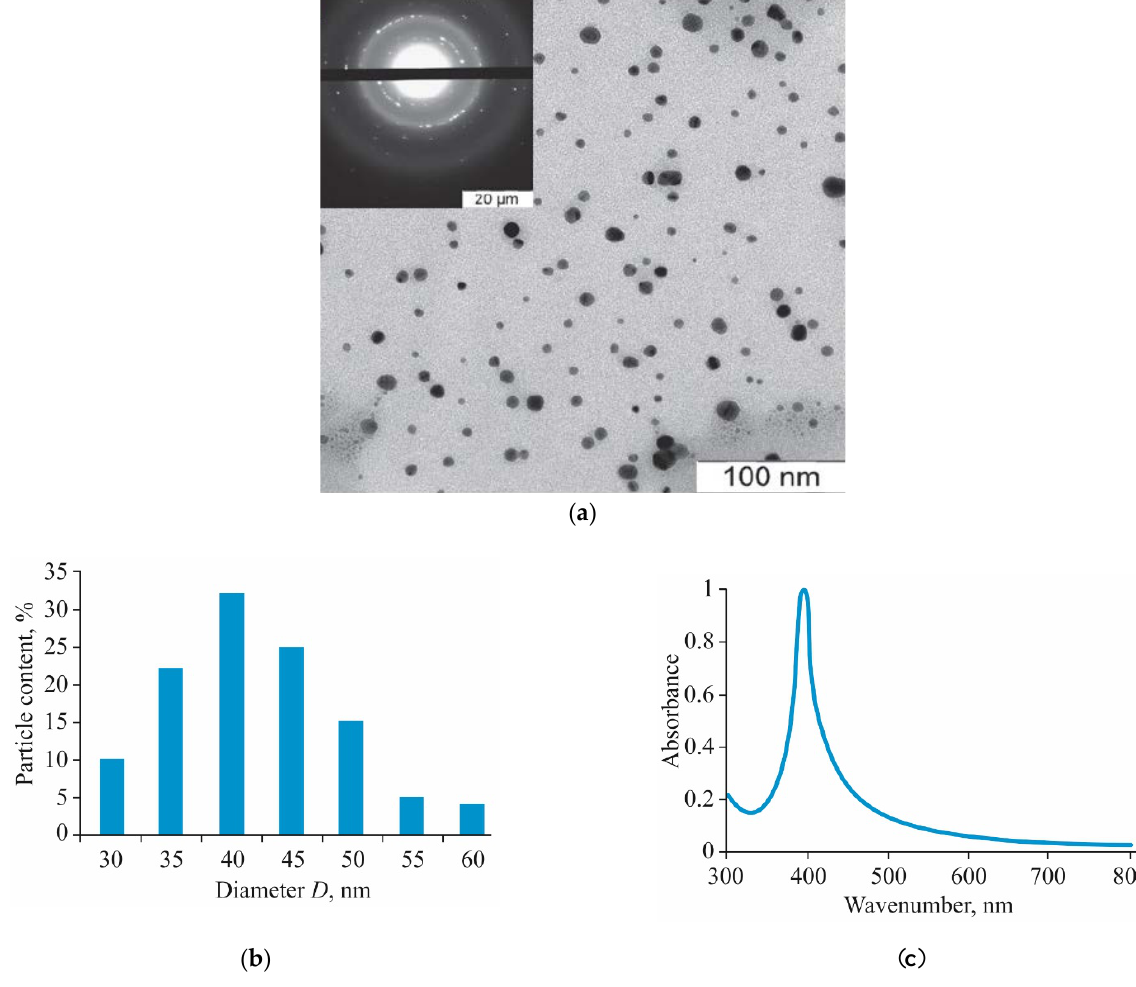
Figure 1. TEM image of silver nanoparticles (AgNPs) ( a ), size distribution histogram ( b ) and UV-visible absorbance spectrum ( c ) of AgNPs stabilized with benzyldimethyl[3-myristoylamine)-propyl]ammonium chloride monohydrate (AgNPs-BAC). AgNPs-BAC is a dispersion of yellow color with a red–orange shade with pH 7.0– 8.0. The ultraviolet-visible (UV-Vis) absorption spectrum (Figure 1c) of AgNPs-BAC has